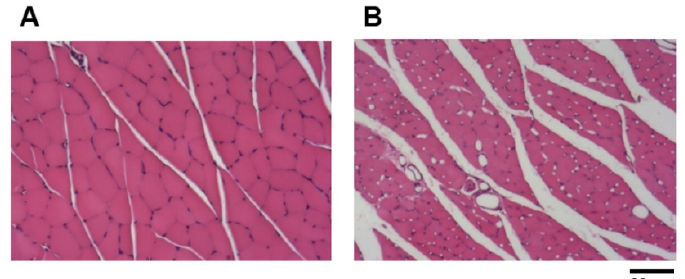
Figure 4. ( A ) Normal rat gastrocnemius muscle. ( B ) Evident muscle atrophy is noted in all of the taxol- treated rats with or without electrical stimulation. Scale bar = 80 μ m.